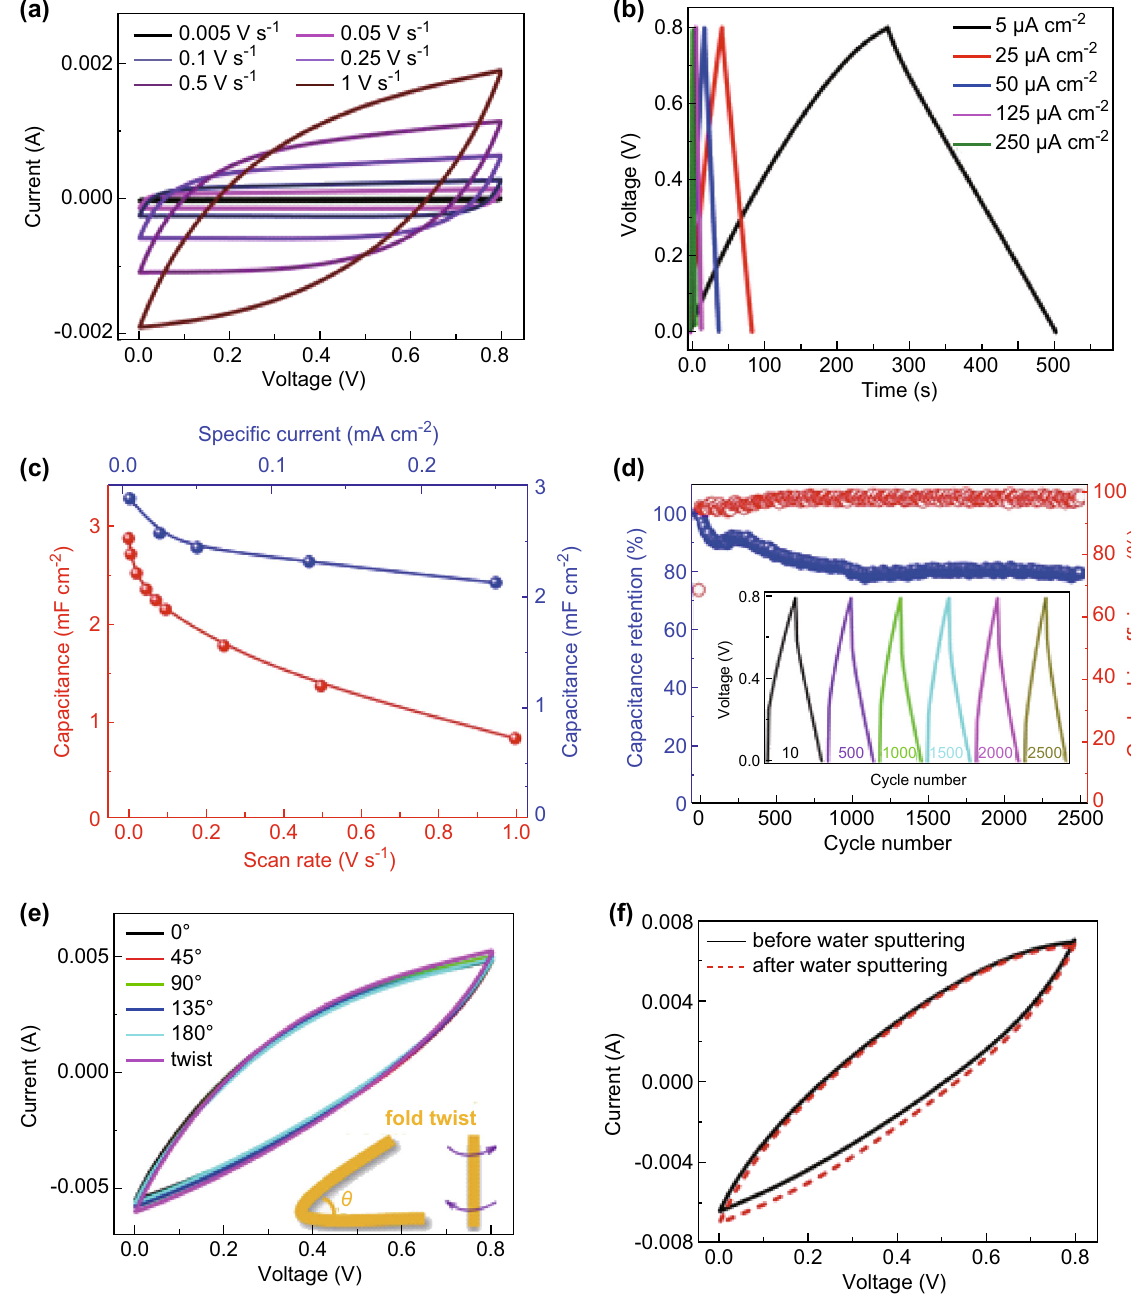
Fig. 3 a CV profiles at scan rates ranging from 0.005 to 1 V s - 1 . b GCD profiles at current densities ranging from 5 to 250 l A cm - 2 . c Areal capacitances calculated according to CV (red) and GCD (blue) profiles of the PPy@CNT sheet electrode using the miwPU polyelectrolyte. d Charge/discharge cycling stability (Inset is GCD curves at various cycle numbers). e CV profiles of the supercapacitor undergoing consecutive deformations (scan rate: 0.05 V s - 1 ). f CV profiles of the waterproof spray-sprinkled supercapacitor prior to and after water sputtering (scan rate: 0.1 V s - 1